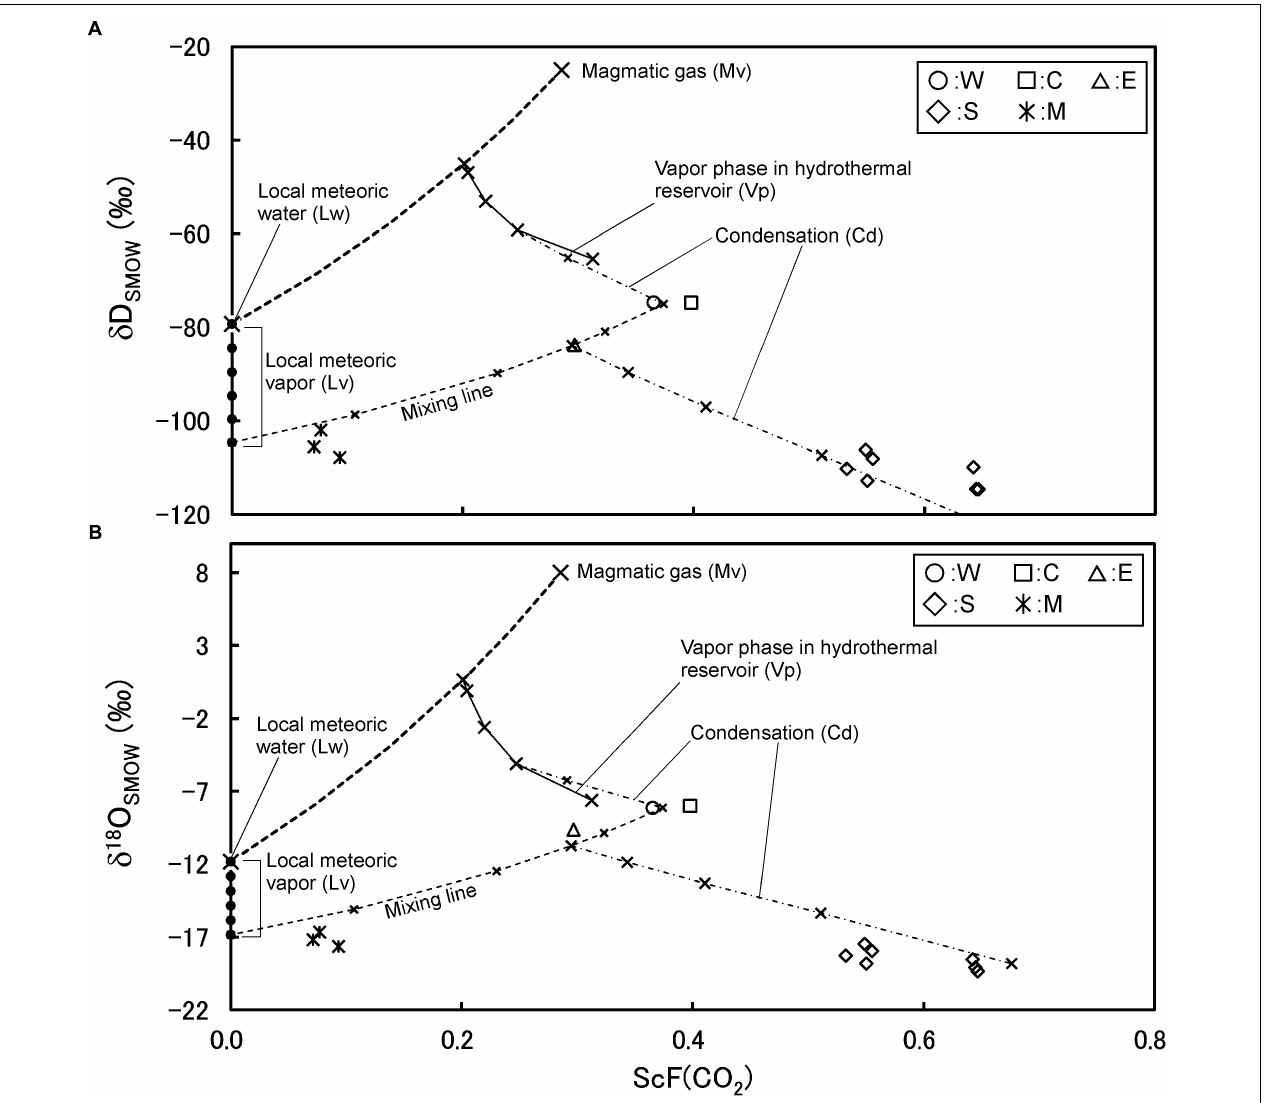
FIGURE 12 | Correlation between isotopic ratios and CO 2 /H 2 O molar ratio for fumarolic gasses and modeled vapor phase. ScF(CO 2 ) is the scaled CO 2 fraction in H 2 O-CO 2 binary